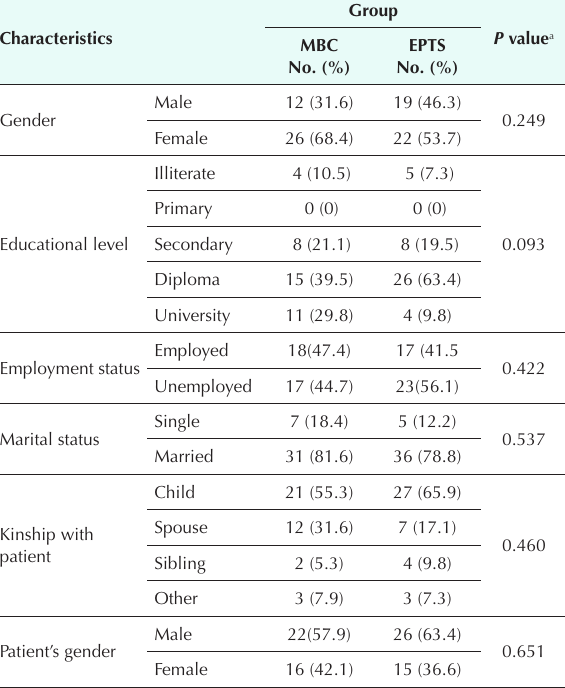
Table 1. Between-group comparisons respecting participants’ characteristics